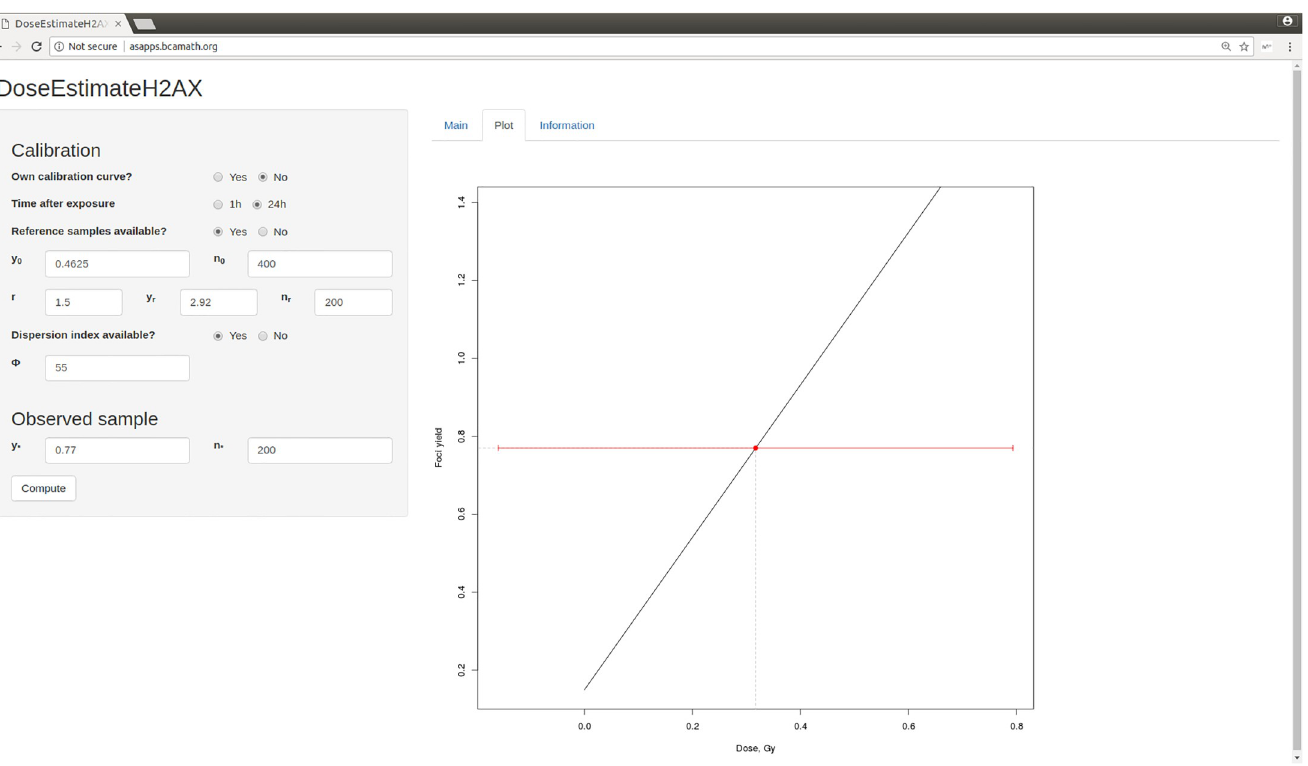
Fig 8. Illustration of web applet using the 24h curve with y � = 0.77 and n � = 200, as well as reference samples according to Table 4. The point estimate x � and the interval estimate x � ± 1.96SE( x � ) of dose are highlighted through a red dot and line, respectively. Numerical output can be obtained by clicking on the “Main” button, see the Tutorial in S1 File for details.